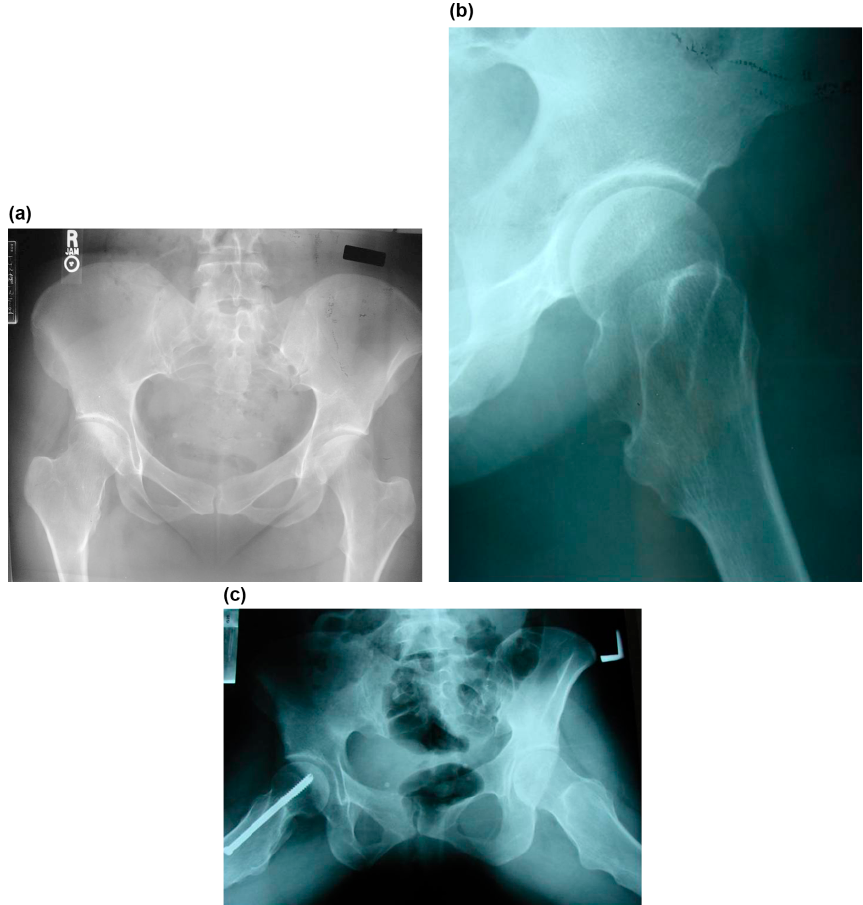
Figure 1. A 14-year-old girl complained of posterior thigh pain at the right lower extremity that was aggravated with straight-leg raising (case no. 2). ( a ) Preoperative anteroposterior radiograph of the right hip shows a small bump at the medial side of the femoral neck. ( b ) Preoperative lateral radiograph of the right hip shows a large bump at the posterior side of the femoral neck. ( c ) The sciatica-like symptom was completely resolved after complete resection of the osteochondromas of the posterior femoral neck.